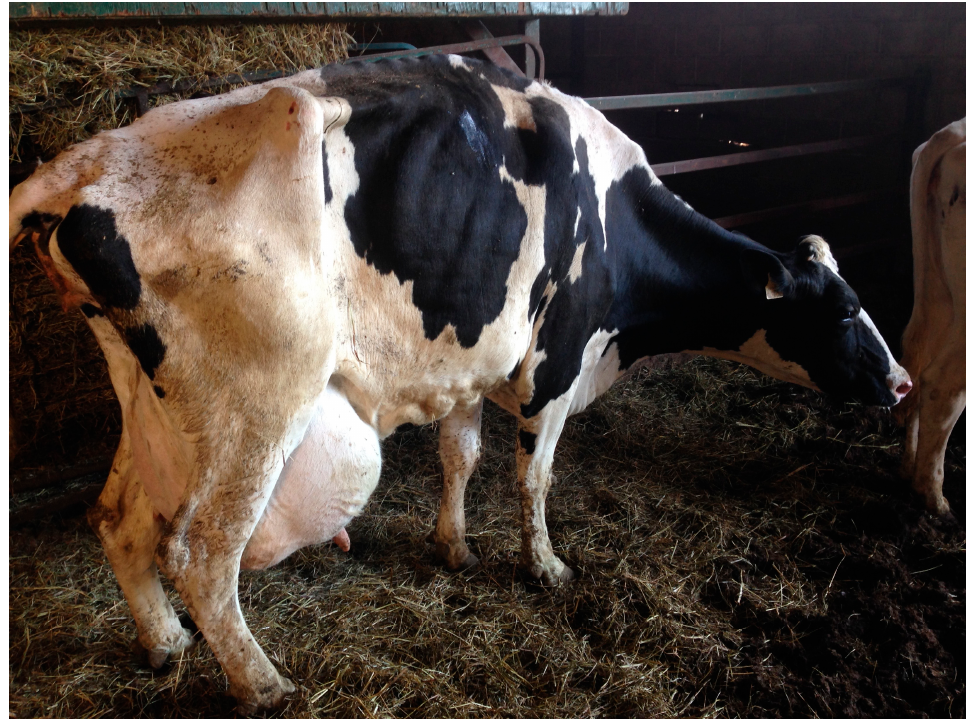
Figure 1. Severely lame dairy cow in very poor body condition presented at a livestock sales barn.